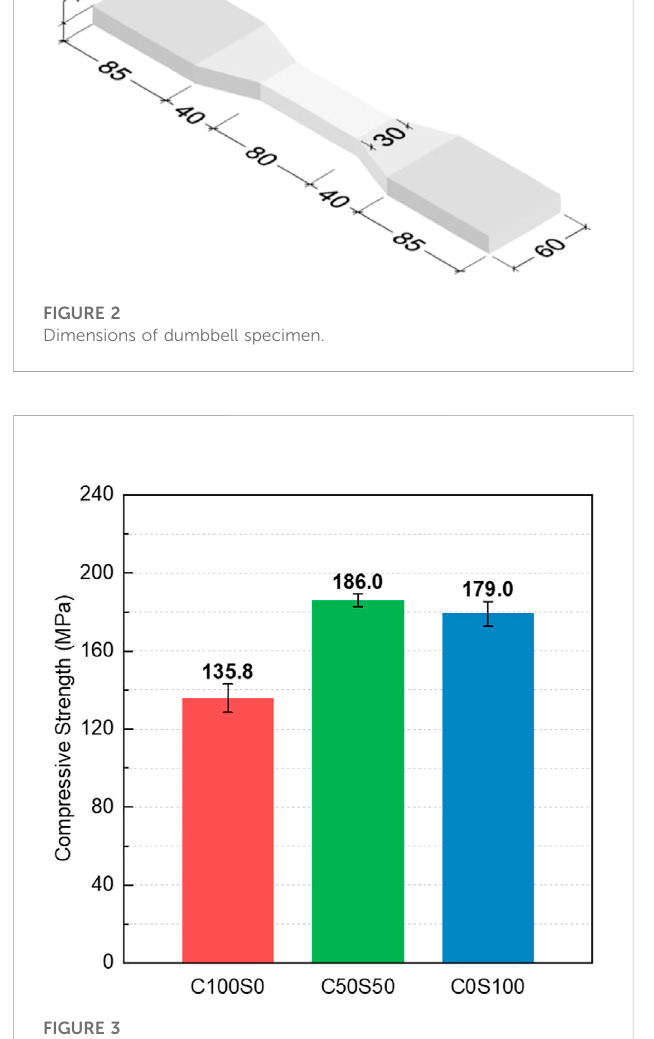
FIGURE 3 Compressive strength of SH-UHPGC with different activators.